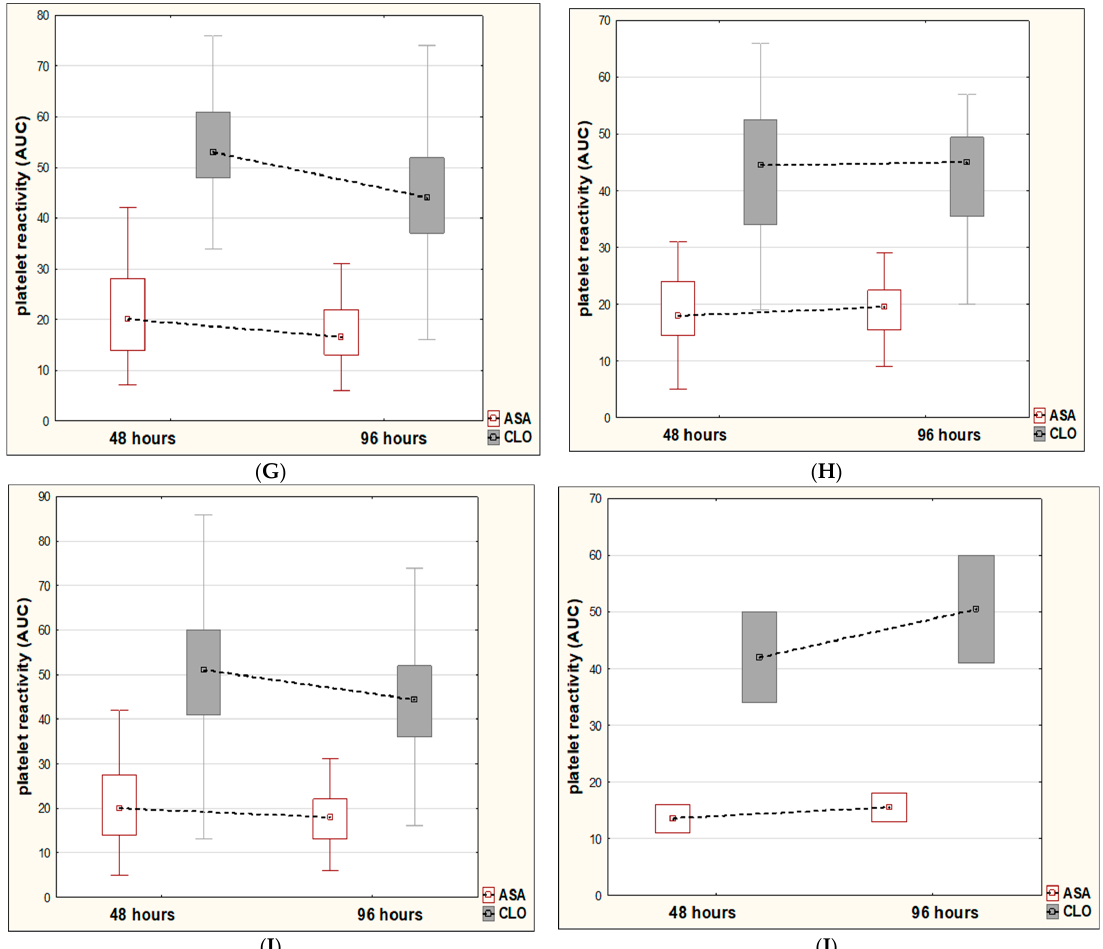
Figure 2. Predictors of significant and favorable dynamics of platelet reactivity (in area under the curve units, AUC) over time in the dual antiplatelet therapy group. The significant and favorable decrease in platelet reactivity between two assessments in relation to clopidogrel (CLO) were reported in subjects with small-vessel disease ( A ), an absence of diabetes mellitus ( C ), an absence of hyperlipidemia ( E ), female sex ( G ), and an absence of alcohol abuse ( I ). The dynamics of platelet reactivity in relation to aspirin (ASA) showed a favorable decrease in the majority of the above cases. The insignificant and largely unfavorable increase in platelet reactivity between two assessments in relation to clopidogrel (CLO) were reported in subjects with large-vessel disease ( B ), diabetes mellitus ( D ), hyperlipidemia ( F ), male sex ( H ), and alcohol abuse ( J ). The dynamics of platelet reactivity in relation to aspirin (ASA) showed an unfavorable increase in the majority of the above cases. Table 4. Comparison of the dynamics of platelet reactivity between aspirin and clopidogrel in the minor stoke group with dual antiplatelet therapy. Parameter